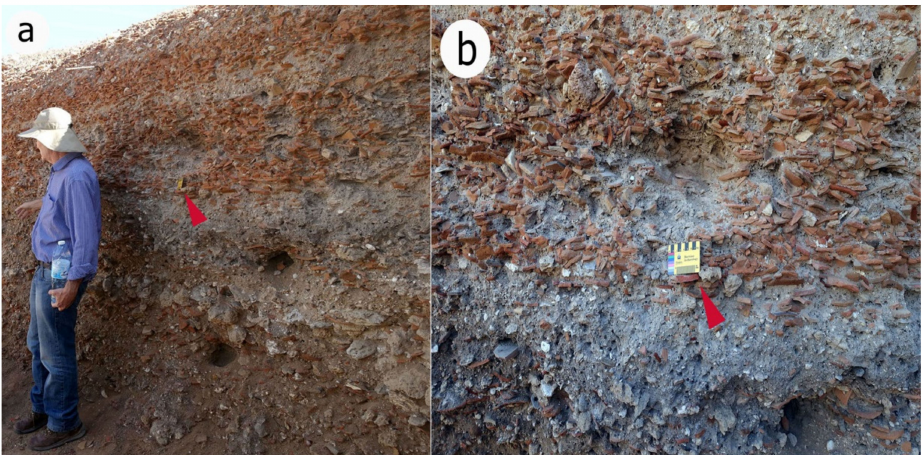
Figure 14. A deposit of broken pottery in the Roman circus (up to 3 m thick): ( a ) general view, looking north-east (location of scale is marked with red arrow), ( b ) detailed view, looking west (scale in centimeters). Goodman-Tchernov and Austin [9] proposed that the fill consists of tsunamigenic deposits dated to the 6th and the 8th century CE. It should be noted that the excavator identified the deposit as Late Roman-Byzantine urban-waste fill (Porath Y. personal communication) (for location see Figures 6d and 15).